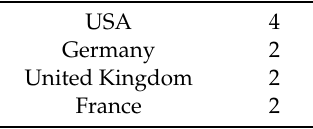
Table 3. Main Location of the Top 10 Galleries Participating to the 2019 Edition of Art Basel in the “Gallery”